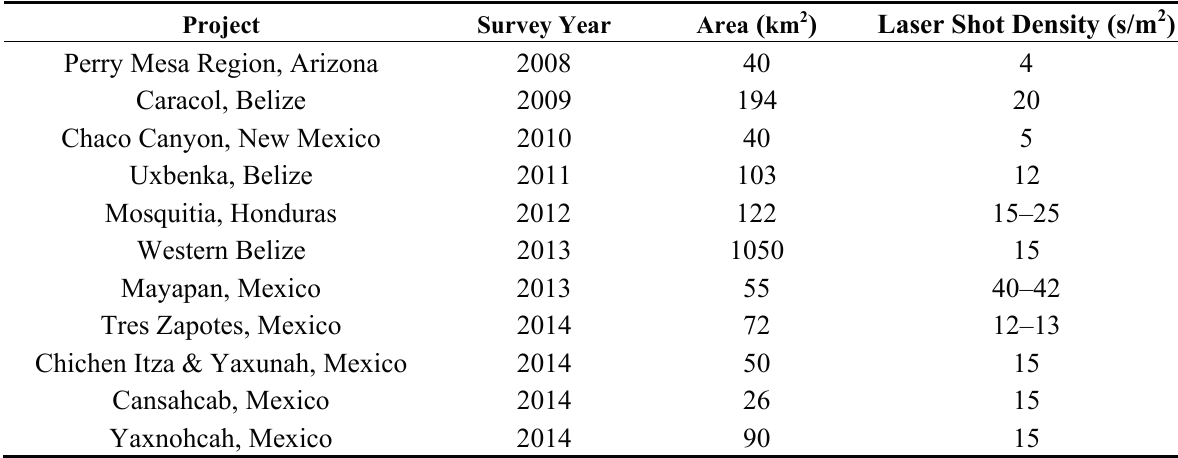
Table 1. Archaeological Airborne Laser Scanning (ALS) survey projects by the National Center for Airborne Laser Mapping